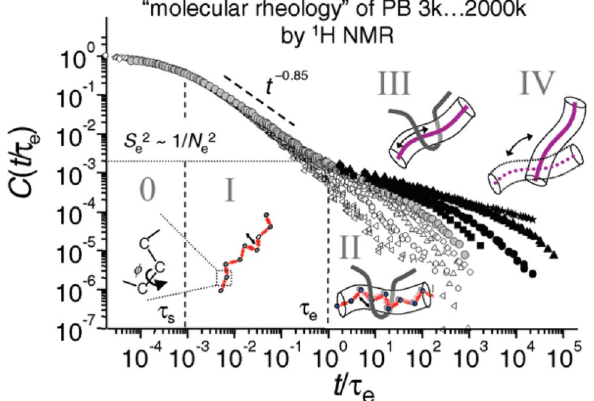
Fig. 13 Entangled polymer dynamics: universal behavior of flexible homopolymers and applicability of the tube model—Bruker Min- ispec